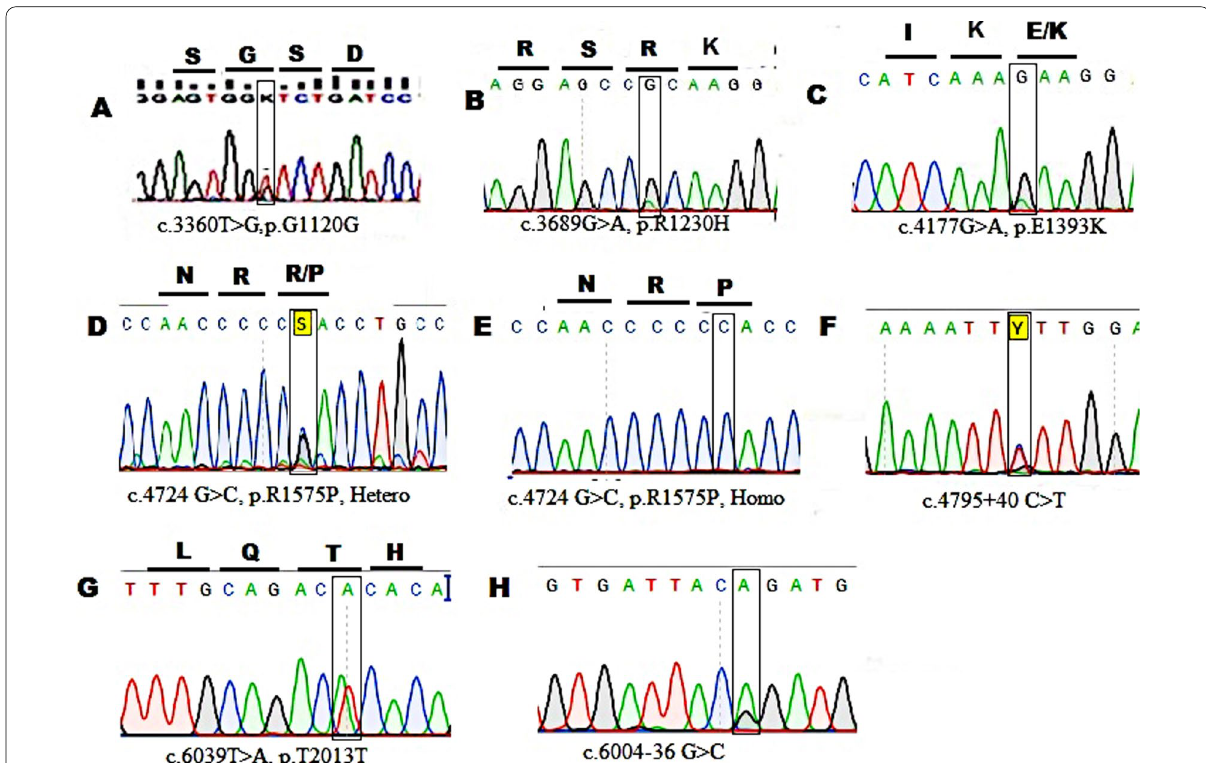
Fig. 1 The chromatograms of obtained variants from direct sequencing and visually inspected by Finch TV. each variant called according to HGVS criteria and ordered in ascending manner from exon 9 to exon 27, where A designate the exon 9 non sense SNP B designate the exon 12 missense SNP C designate the exon 15 missense SNP D designate the exon 19 heterozygous missense SNP E designate the exon 19 homozygous missense SNP. F designate the intronic SNP in exon 19. G designate the non sense SNP in exon 27. H designate the intronic SNP in exon 27; Each vertical rectangle mark the location of SNP and each codon change leading to amino acid change designated by upper line with the codon and its relative amino